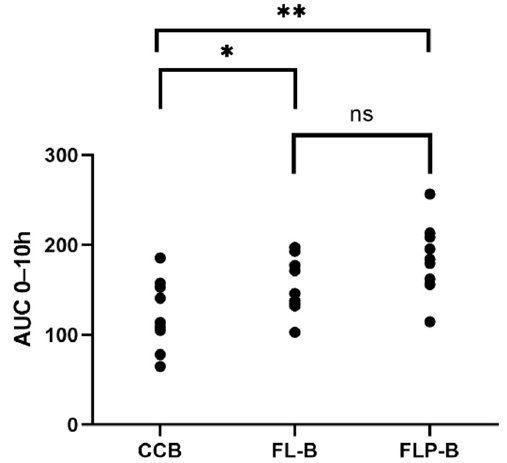
Figure 8. Area under curve values from time 0 h to time 10 h obtained after the instillation of the different formulations, representing the value of each eye. * p < 0.05, ** p < 0.01, ns Non Significant. Subsequently, a determination was made of the differences between the AUC 0–10h and the ∆ IOP max obtained for each formulation (Supplementary material Tables S1–S3).